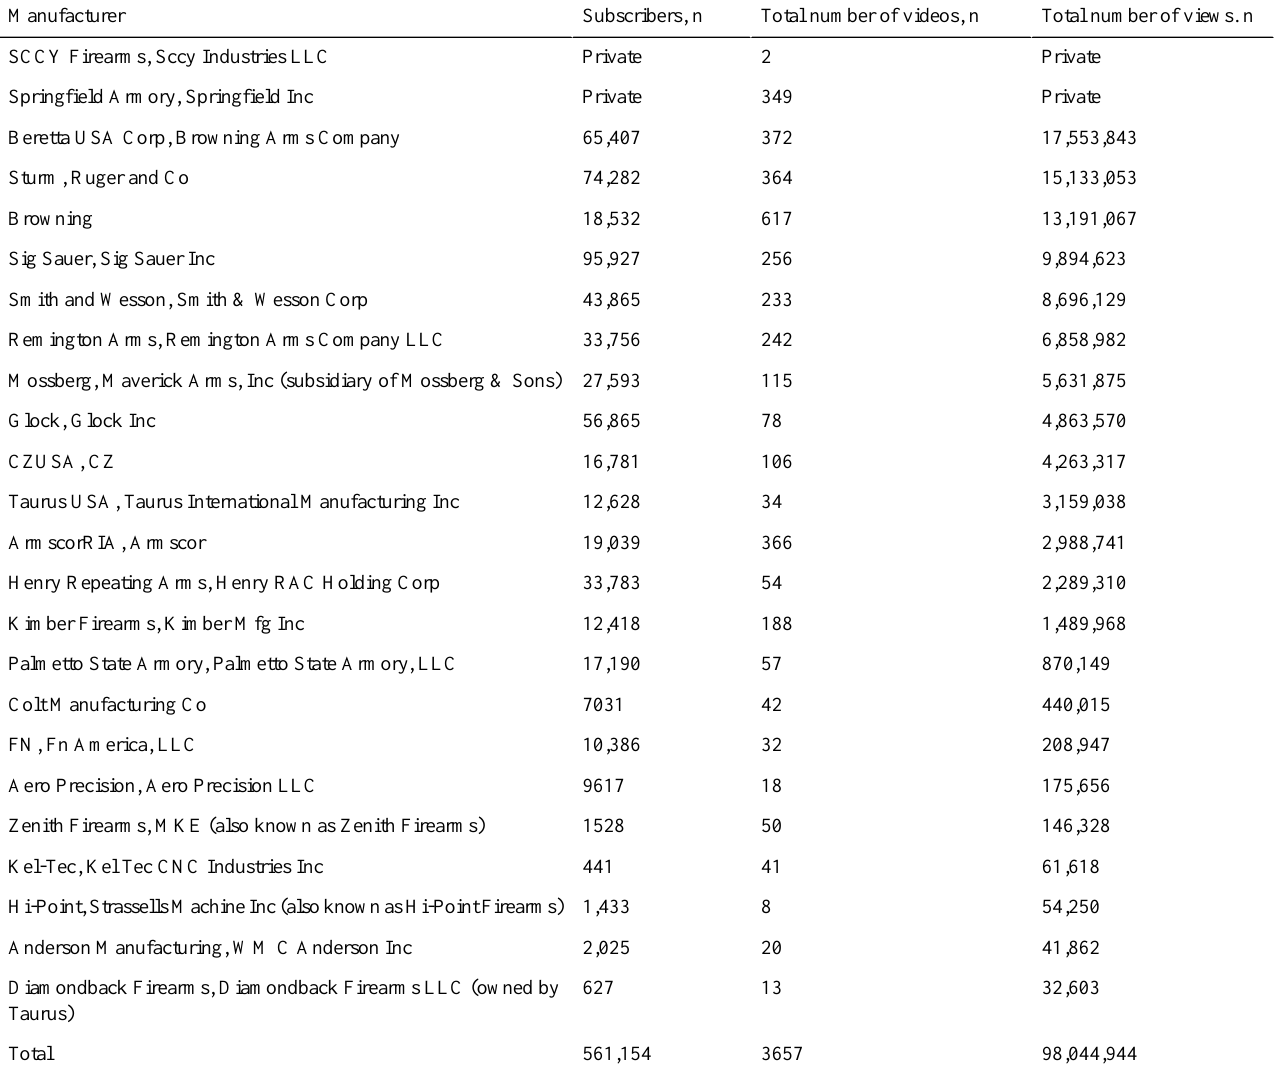
Table 3. Summary of top firearm manufacturers on YouTube by total